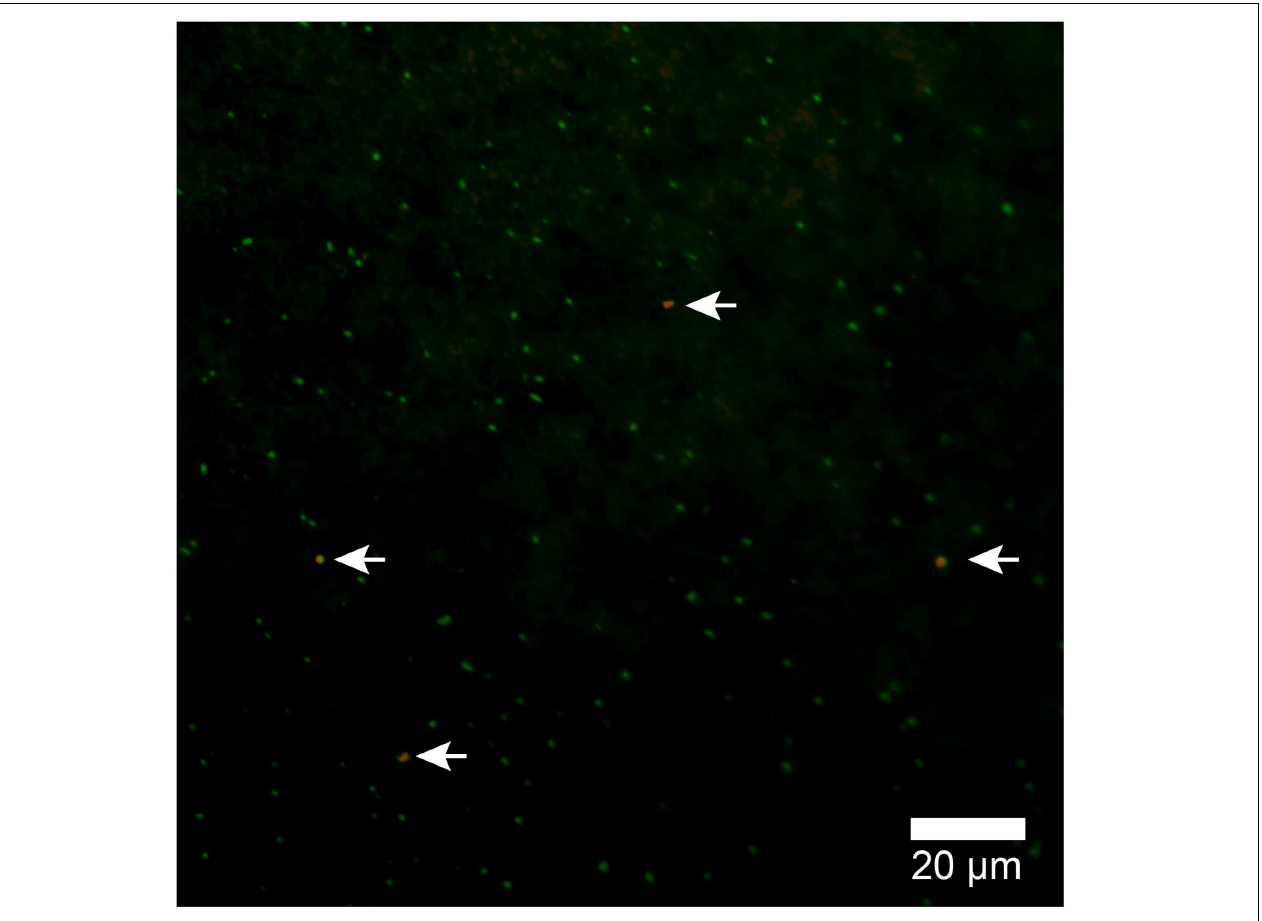
FIGURE 7 | Atribacterial cells detected by CARD-FISH using probe Atri578. Alexa555-labeled tyramide was used for horseradish peroxidase (HRP) detection (appears orange) and DNA was counterstained with SYBR Green I. White arrows point to orange cells ( Atribacteria ); green cells are other microbial cells.